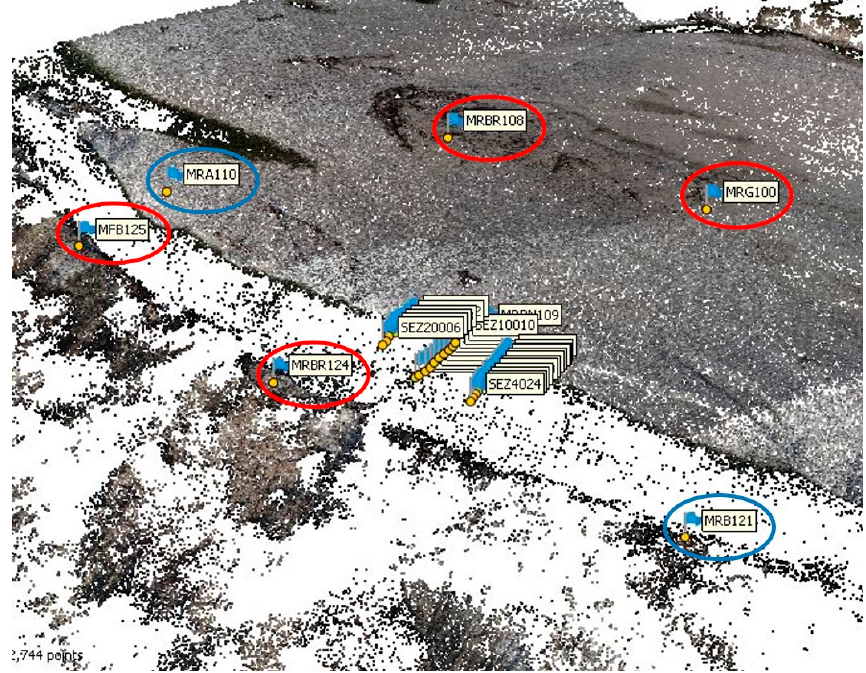
Figure 4. Example of GCPs (red boxes) and CPs (blu boxes) distribution patterns. Some bathymetric sections on the riverbed are also shown.